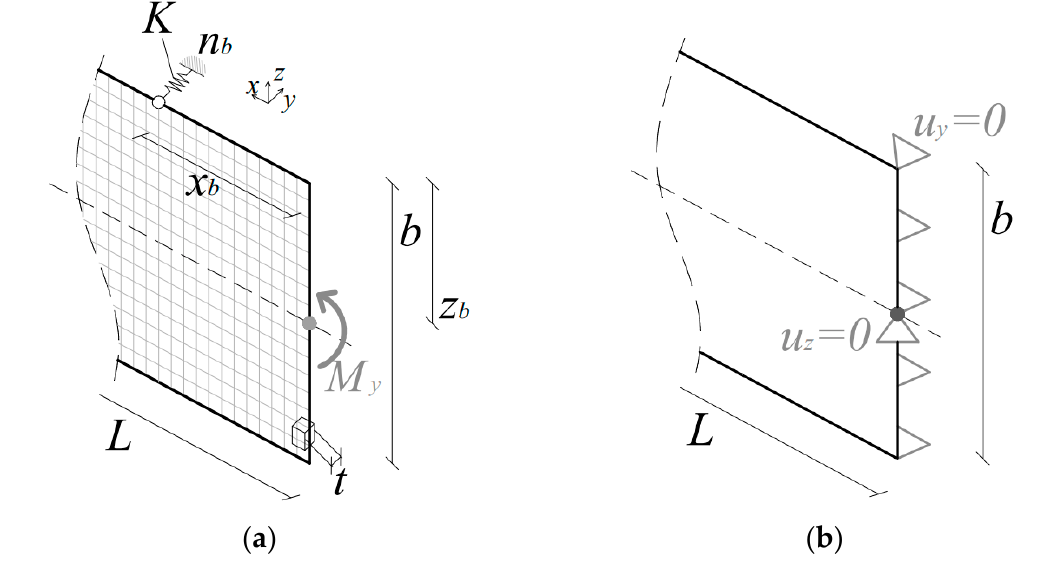
Figure 8. Preliminary finite element (FE) numerical model for linear bifurcation analyses on LR glass beams in LTB (ABAQUS).